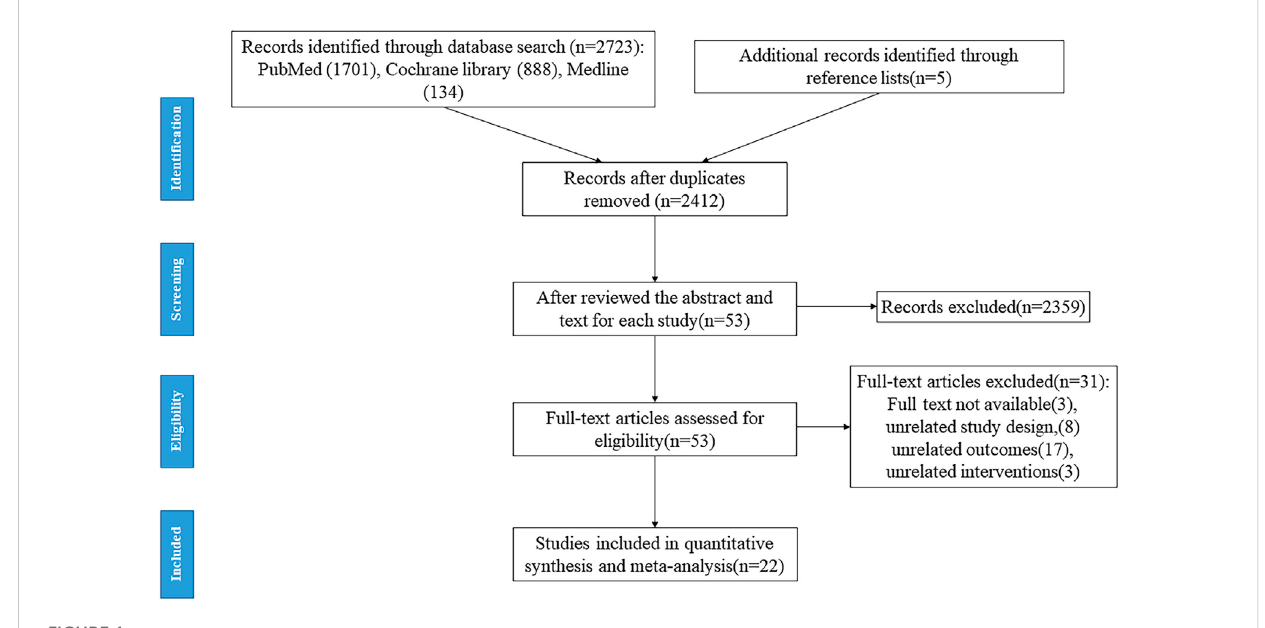
FIGURE 1 The fl ow diagram of the selection